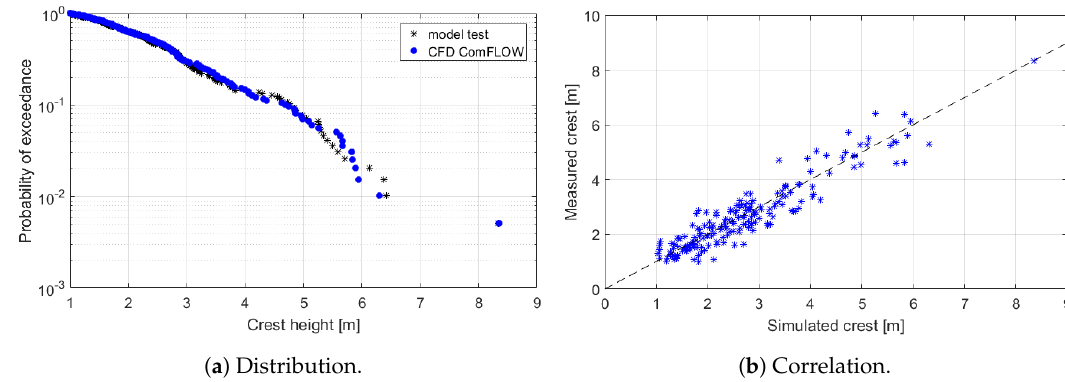
( a ) Distribution. ( b ) Correlation. Figure 12. Measured and simulated wave crest distribution and individual crest correlation for measured and simulated wave elevation signal, both at probe